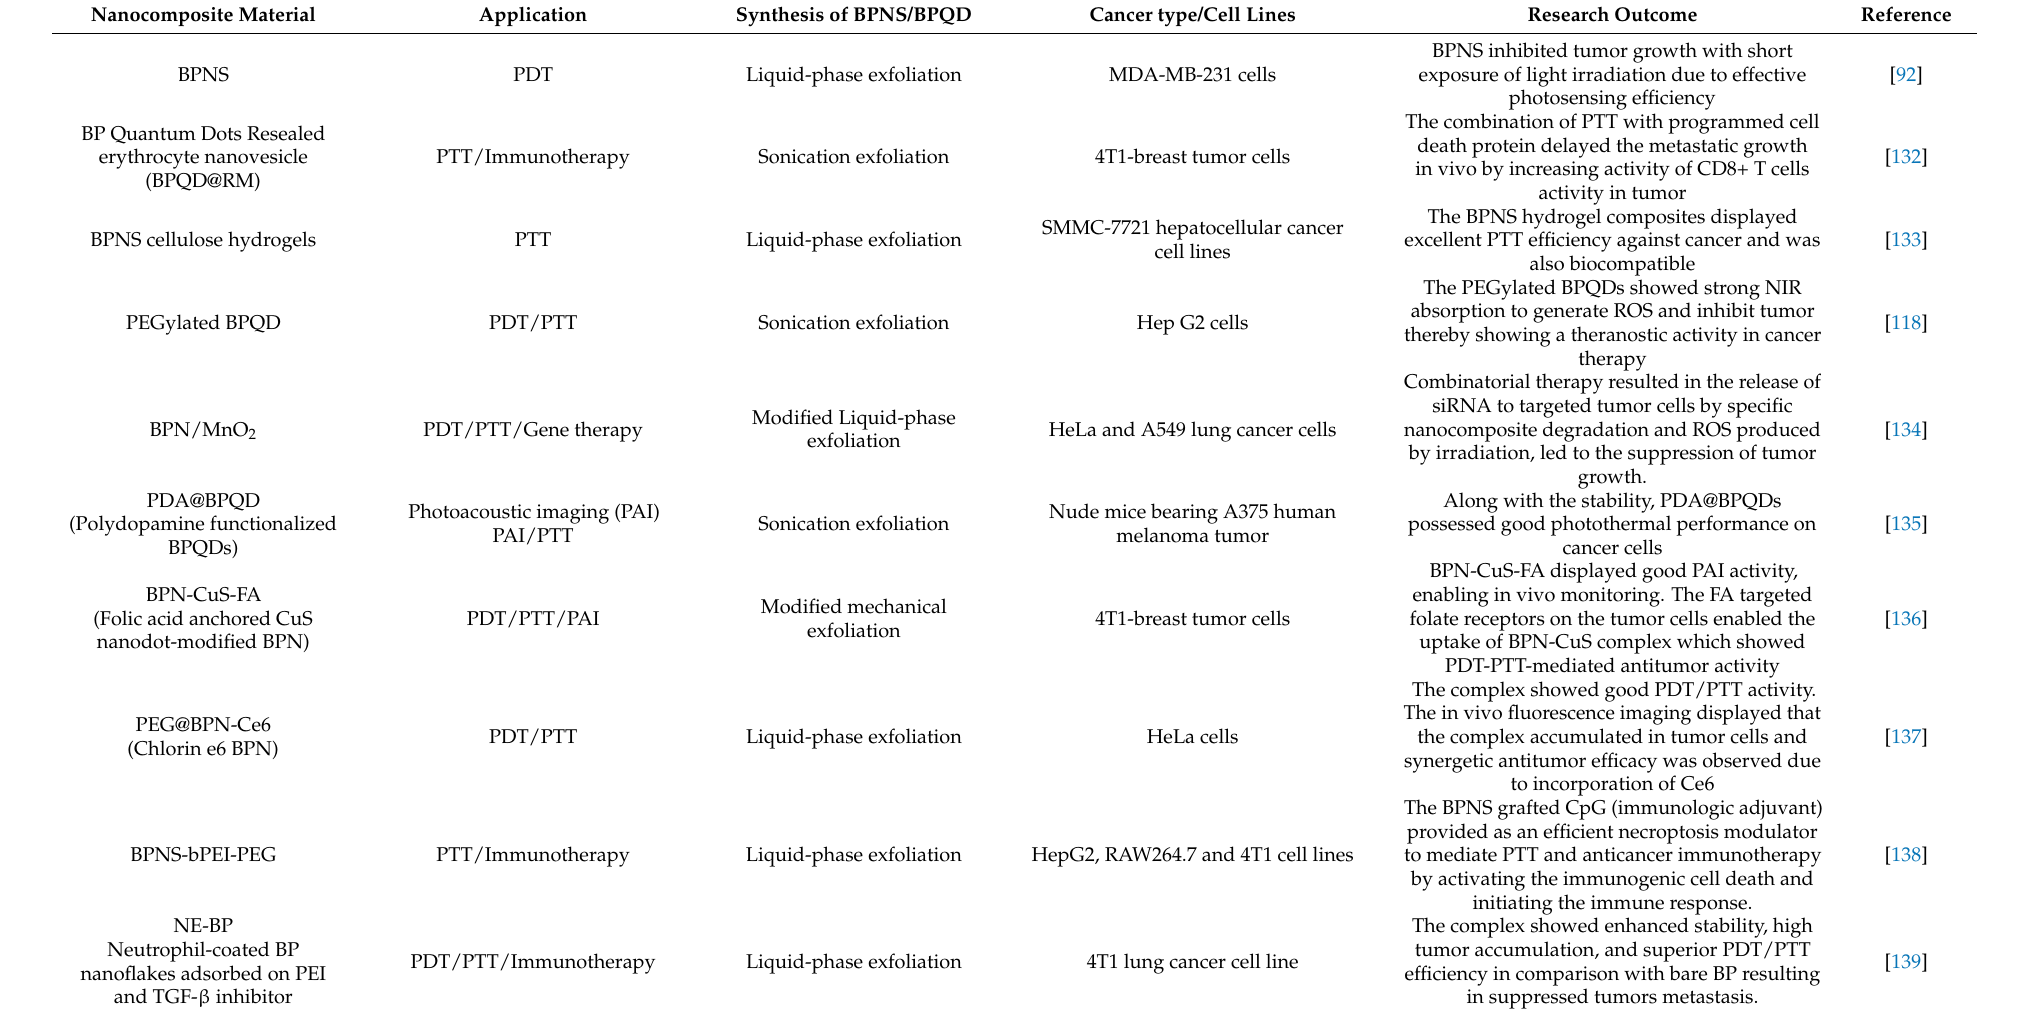
Table 3. Summary of applications of BP in therapy of